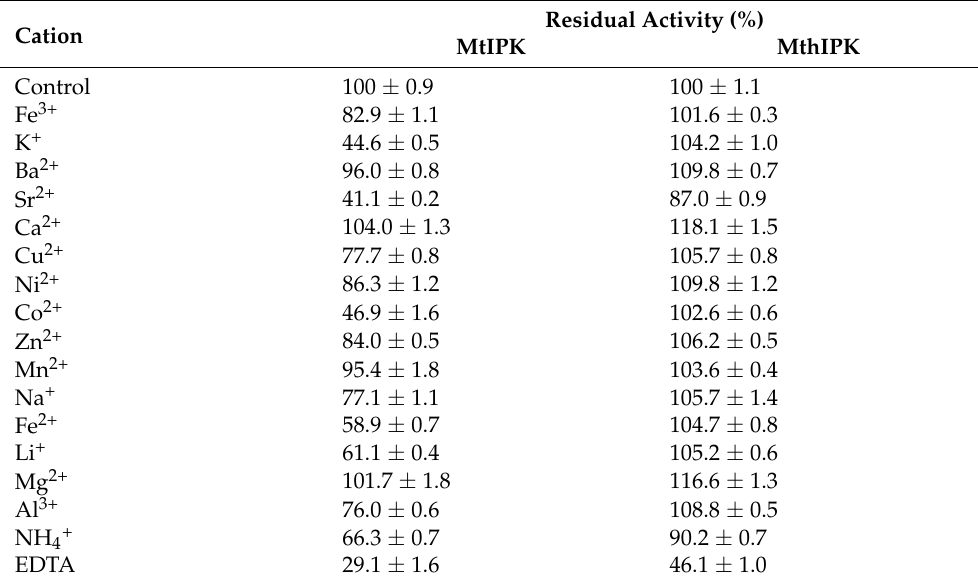
Table 3. Effects of cations and EDTA on the activities of MtIPK and